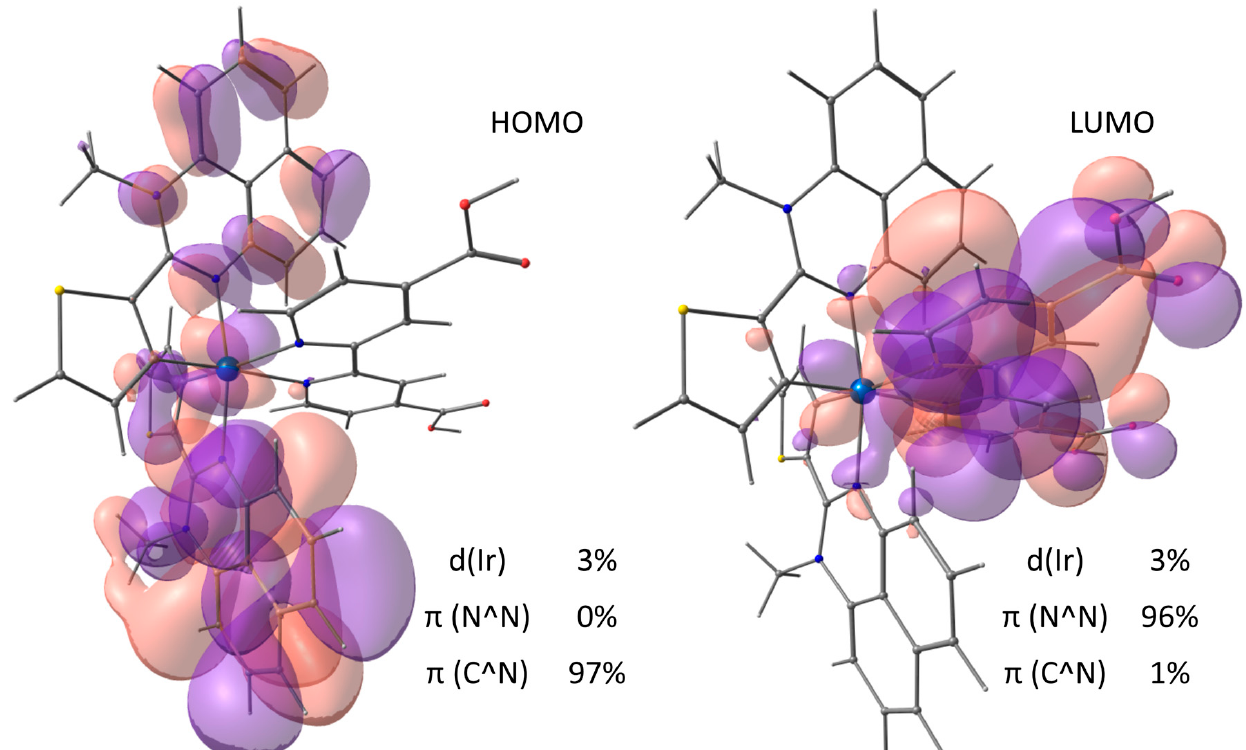
Figure 8. Frontier molecular orbitals and their compositions calculated for complex 2 .